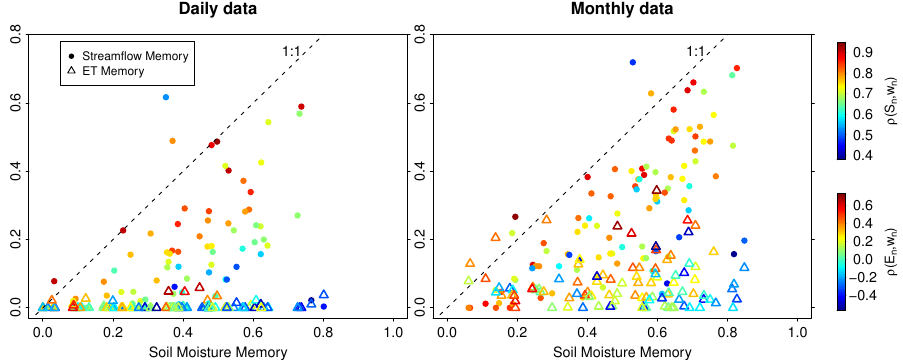
(cid:16) (cid:17) Q n ,Q n + t Fig. 6. Streamflow (dots) and ET (triangles) memories ρ and ρ (cid:0) E n ,E n + lag (cid:1) , respectively, of all selected catchments plotted Figure 6: Streamflow (dots) and ET (triangles) memories ρ ( Q n ,Q n + lag ) and ρ ( E n ,E n + lag ) , respectively, of all lag selected catchments plotted versus the corresponding soil moisture memories ρ ( w n ,w n + lag ) for daily and monthly versus the corresponding soil moisture memories ρ (cid:0) w n ,w n + lag (cid:1) for daily and monthly averaged data (all memories computed for a lag of averaged data (all memories computed for a lag of 30 days (daily data) or 1 month (monthly data)). The color 30 days (daily data) or 1 month (monthly data)). The colour coding denotes the strength of the soil moisture-streamflow coupling ρ (Q n ,w n ) coding denotes the strength of the soil moisture-streamflow coupling ρ ( Q n ,w n ) and the soil moisture-ET coupling and the soil moisture-ET coupling ρ (E n ,w n ) , respectively (see Sect. 2.5). ρ ( E n ,w n ) , respectively (see Section 2.5).